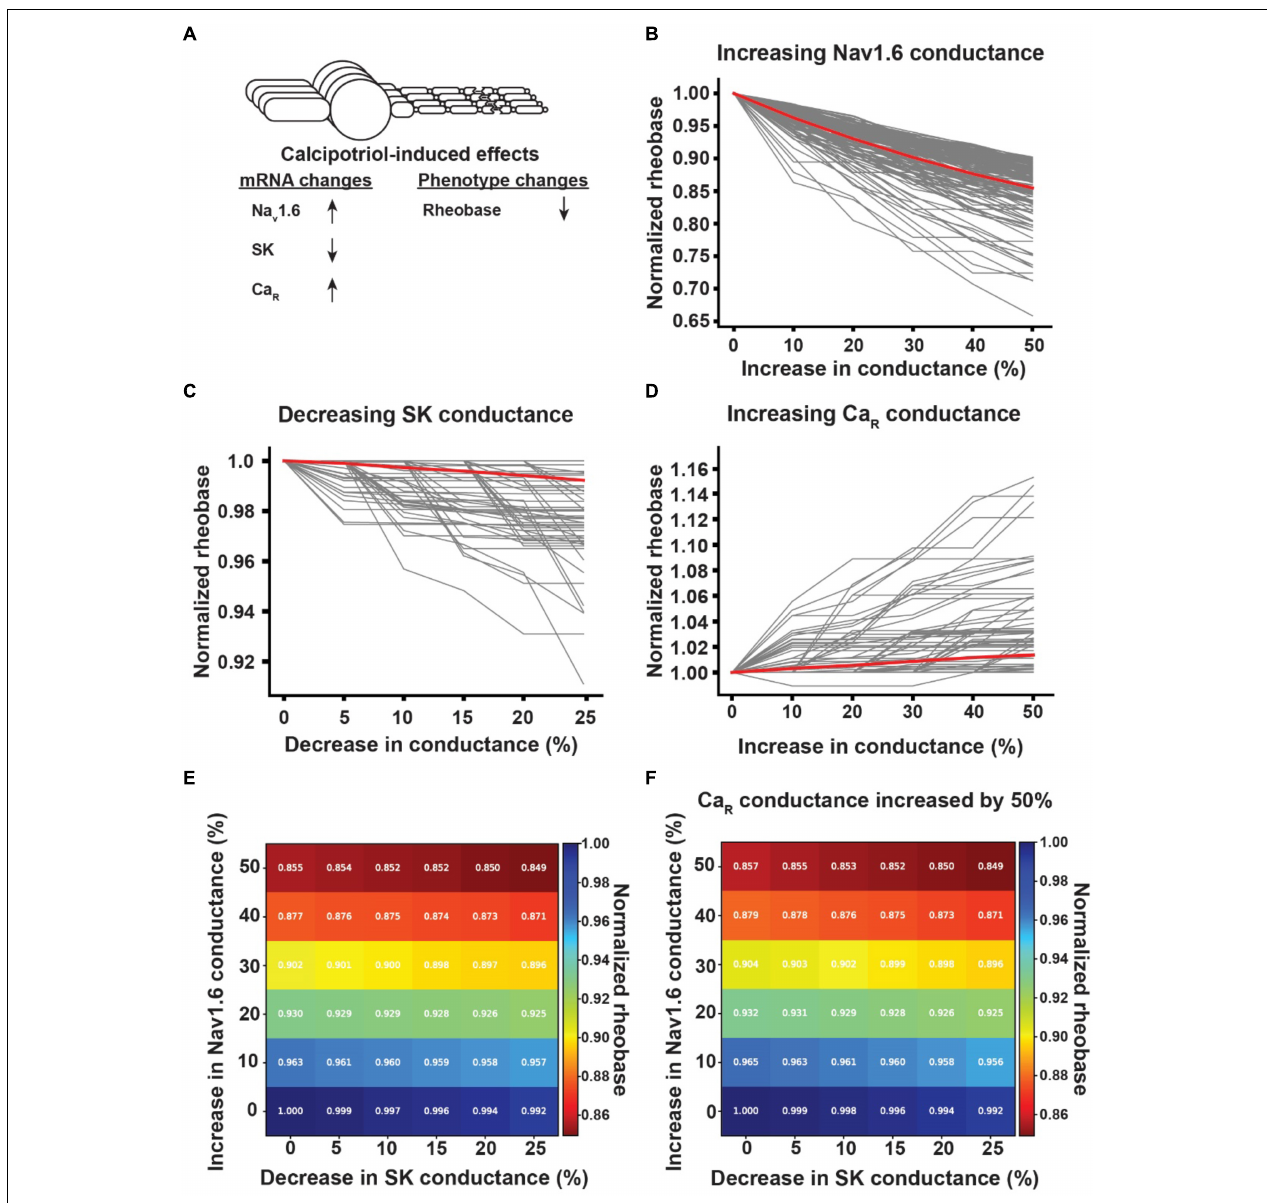
FIGURE 6 | Effect of calcipotriol-induced changes in ion channel expression on the excitability of Ucn3 + neurons. (A) Calcipotriol-induced effects on Ucn3 + neurons. (B) Effect of increasing Nav1.6 conductance on Ucn3 + model neuron rheobases. (C) Effect of decreasing SK conductance on Ucn3 + model neuron rheobases. (D) Effect of increasing Ca2.3-containing R-type Ca channel (Ca R ) conductance on Ucn3 + model neuron rheobases. (E) Effect of simultaneously increasing Nav1.6 conductance and decreasing SK conductance on the average rheobase of the Ucn3 + model neuron population. (F) Effect of simultaneously increasing